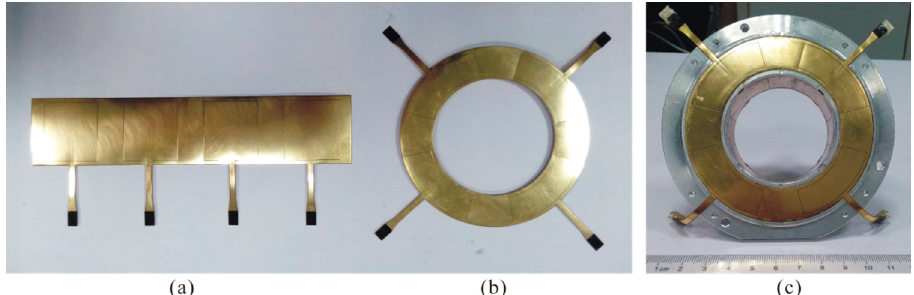
Figure 20. Photograph of the sensing electrode groups and sensor stator: ( a ) Radial sensing electrode group; ( b ) end part sensing electrode group; ( c ) the stator of T-type CS.